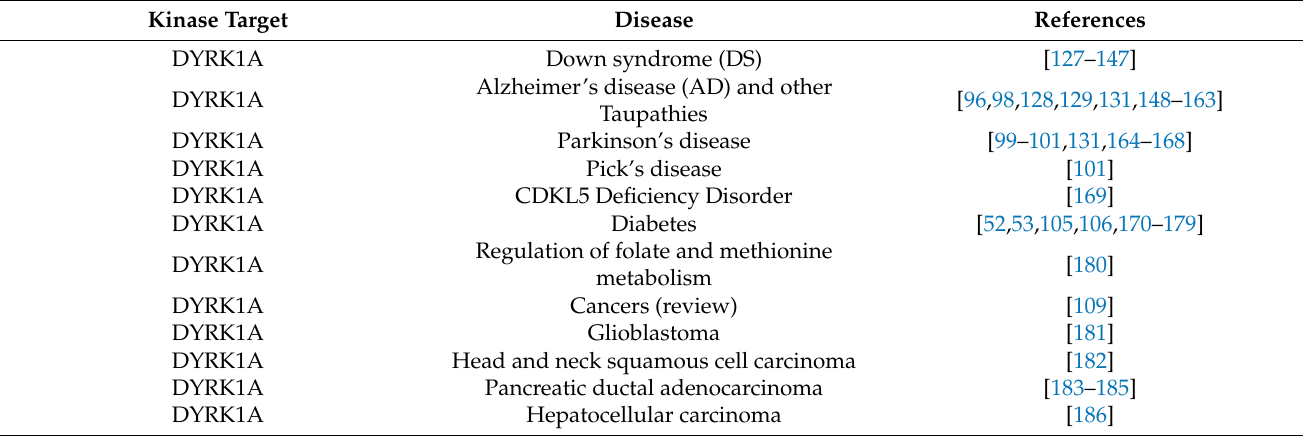
Table 3. DYRKs and human disease. Evidence for causality and beneficial effects of pharmacological treatment by DYRKs inhibitors. Kinase